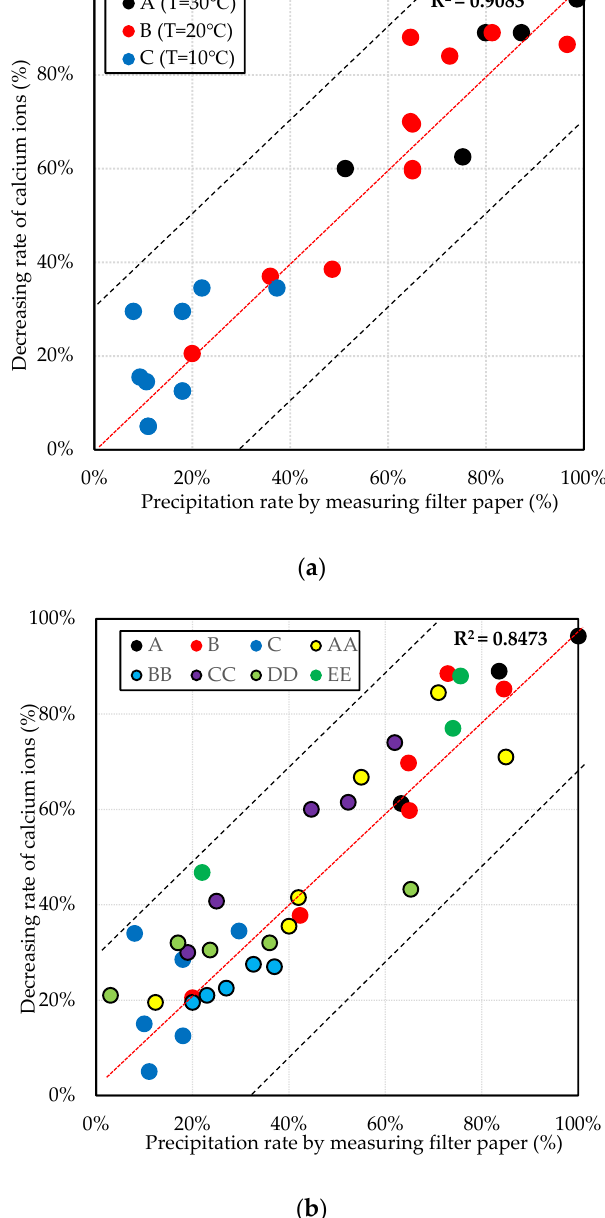
Figure 5. The relation between the decreasing rate of calcium ions and the precipitation rate by filtered paper at ( a ) constant temperature and ( b ) with temperature change.